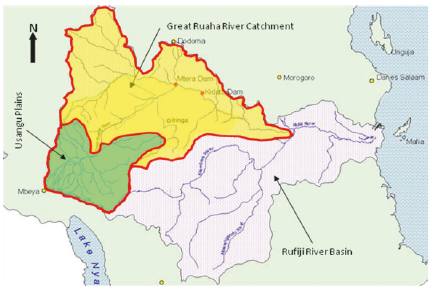
Figure 4: Rufiji basin and its rivers network